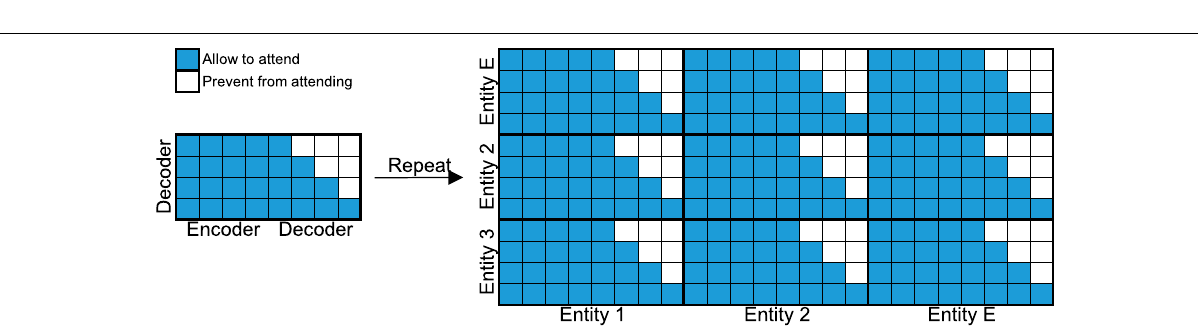
FIGURE 2 | CETFT architecture. Entity encoding networks receive inputs directly related to theirs corresponding entity, and the outputs are concatenated chronologically. The cross-entity attention integrates information from all entities and time frames. Gated residual layers provide enhancement to skip connections. Dense layers generate forecasting results.